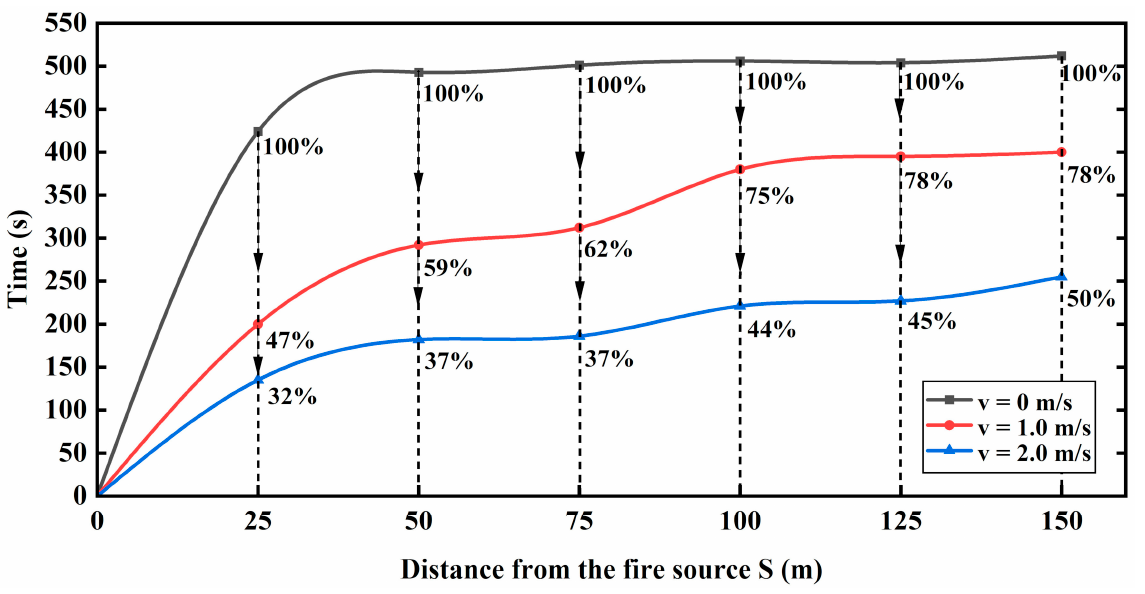
Figure 7. Time of downstream smoke sinking into evacuation space (within 2 m height from the road) after ignition.